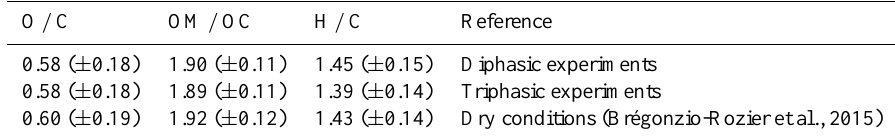
Table 5. Average elemental ratios of SOA from isoprene photooxidation under dry conditions and after cloud generation (diphasic and